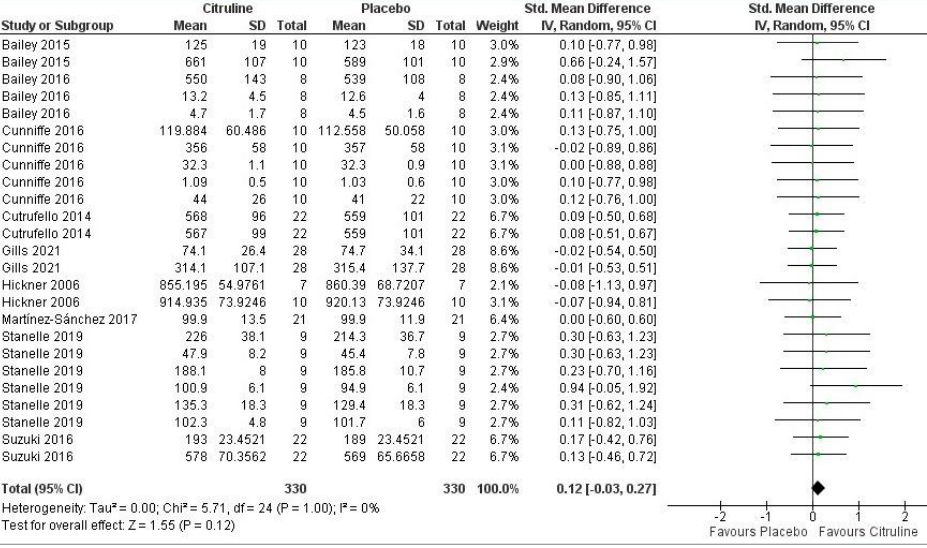
Figure 5. Forest plot comparative study of the effects of Cit supplementation on aerobic sports per- formance ( ≤ VO 2 max.) [43–45,48,49,57–60]. performance ( ≤ VO 2 max.)